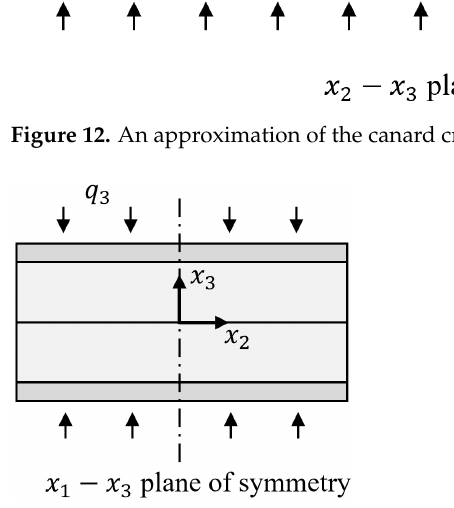
Figure 13. An approximation of the canard cross-section (side-view).